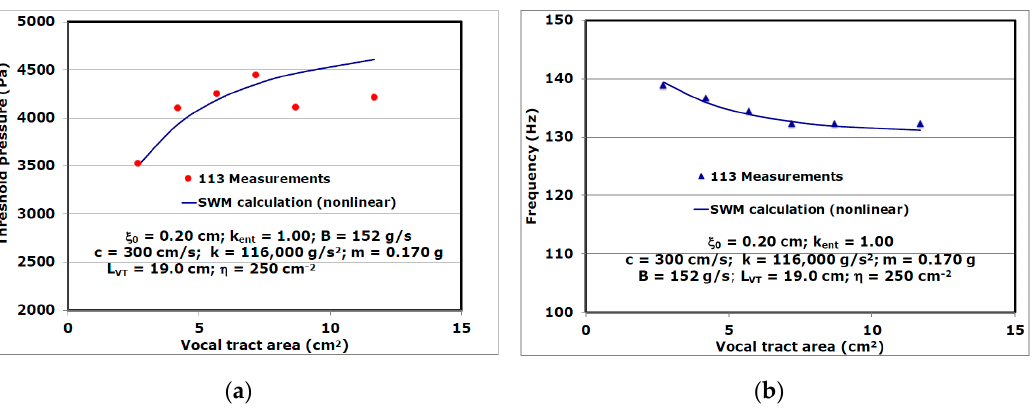
Figure 8. (Color online) ( a ) Measured and calculated threshold pressures for vocal tracts with different areas for vocal fold model 113. ( b ) Measured and calculated frequencies for vocal tracts with different areas for vocal fold model 113.